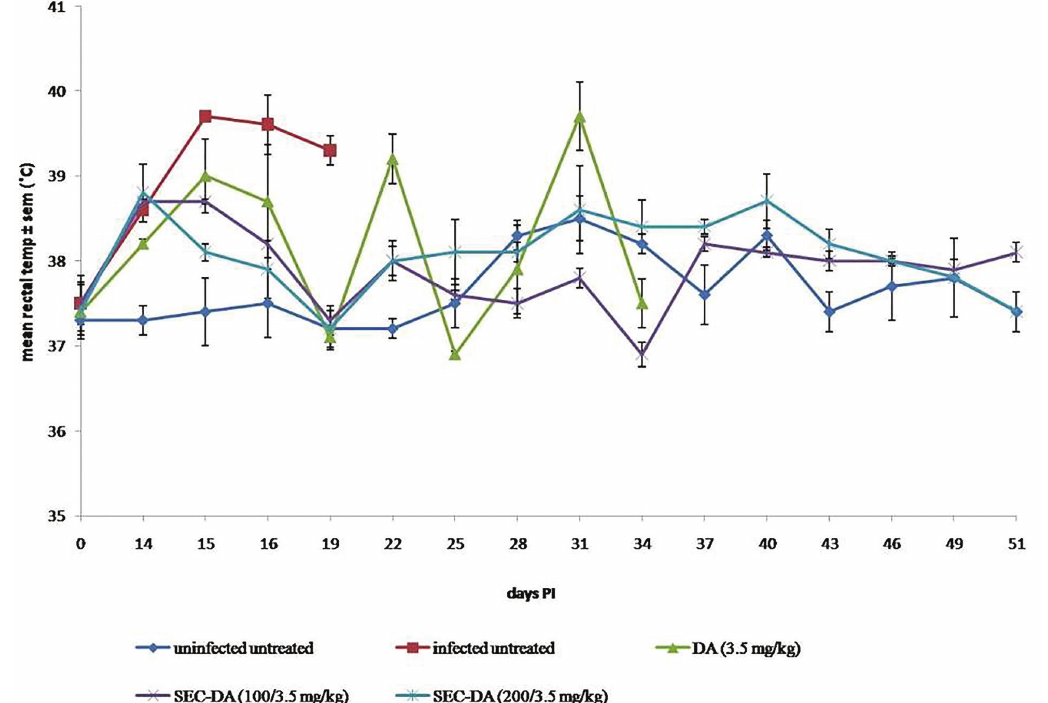
FIGURE 2 - Mean rectal temperatures of dogs infected with T. b. brucei and treated with combinations of SEC-DA and DA monotherapy. Dogs were infected on day 0 and treatment started 14 d.p.i. All infected untreated dogs died before 22 d.p.i. Data collection on rectal temperature for a group was terminated as soon as relapse was recorded for that